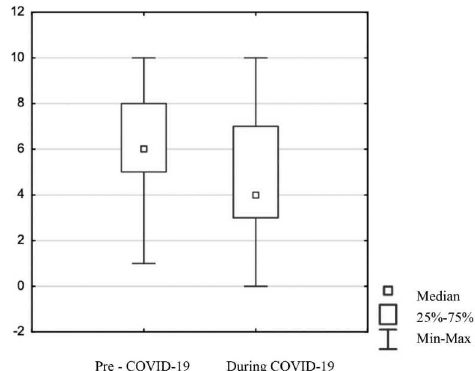
Figure 4. Comparison of scores concerning the quality of health services before and during the COVID-19 pandemic among women